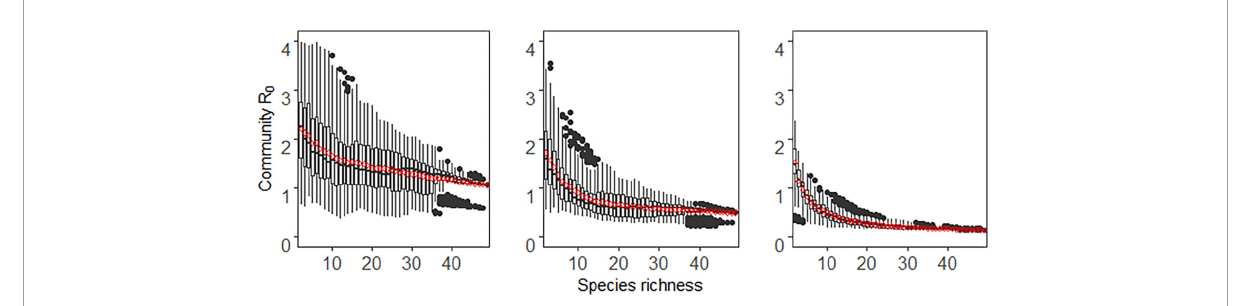
FIGURE3 The relationship between host species richness and community R 0 under frequency-dependent transmission and stochastic extinction scenario. Each column represents different relationship between host competence and abundance. Positive, neutral, and negative correlations are from the first to the third column. Each boxplot represents the values of 1,000 simulations for each species richness level, and the red dots represent the mean values of community R 0 .